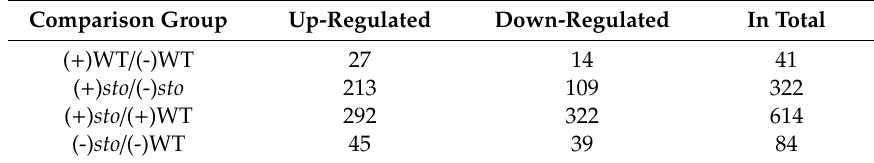
Table 2. Number of di ff erentially expressed proteins in each comparison group.